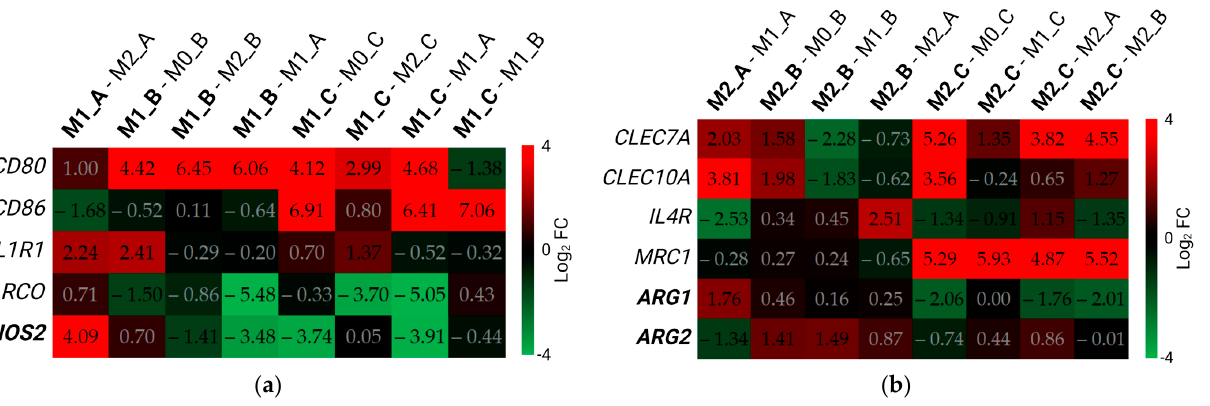
Figure 7. Differential expression of cytokine and chemokine genes. Data in the figure are presented as log 2 (FC). The threshold for differentially expressed genes was set as |log 2 (FC)| ≥ 1 with an adjusted p -value of padj ≤ 0.05. DEGs are represented with digits in black font. Comparisons between different samples are displayed in the upper part of the figure along the x-axis. FC—fold change. DEGs—differentially expressed genes. ( a ) M1 gene set; ( b ) M2 gene set. Created with BioRender.com; accessed on 14 November 2022.